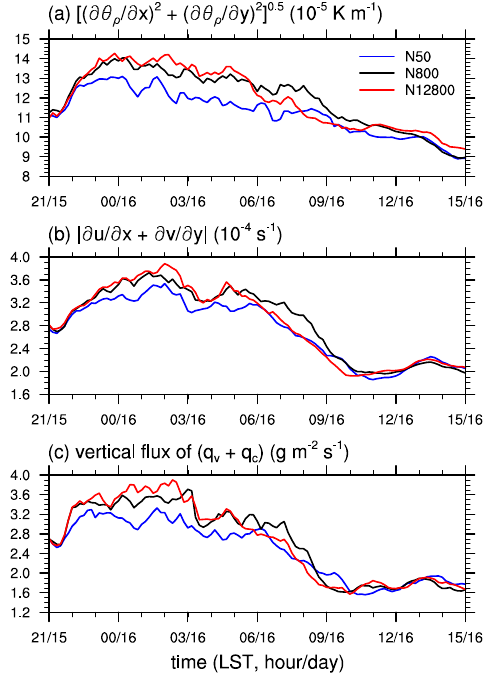
Figure 15. Time series of averaged ( a ) horizontal gradients of density potential temperature ∂θ ρ / ∂ x ∂θ ρ / ∂ y , ( b ) | ∂ u / ∂ x + ∂ v / ∂ y | , and ( c ) upward flux of water vapor and cloud droplets in the N 0 = 50, 800, and 12,800 cm − 3 cases below z = 2 km.